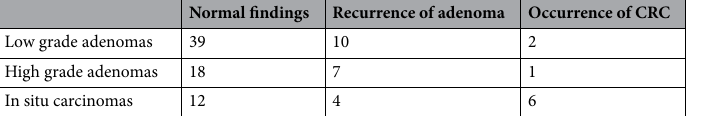
Table 2. Follow up of patients included into the